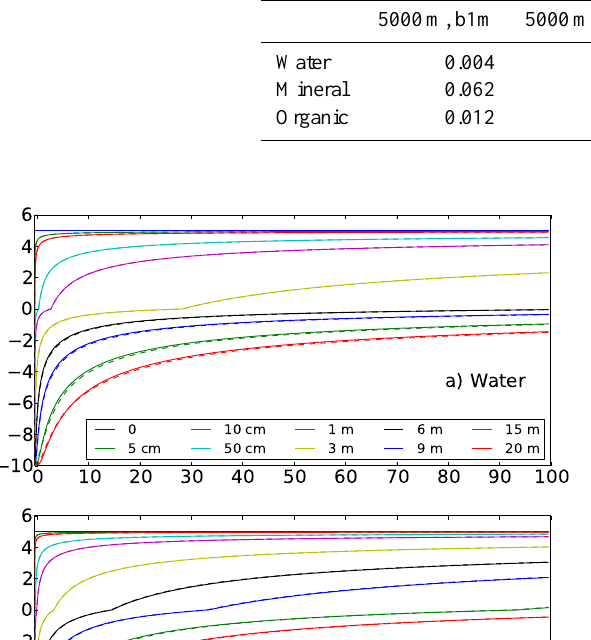
Table 4. The root mean squared error ( n = 36500) between the thawing fronts (m) from exact Neumann solutions and simulated thawing fronts from the DOS-TEM, with different combinations of total thickness (50, 500, and 5000m) and bottom-up forcing (b1m: bottom-up forcing at 1m below front; nobot: no bottom-up forcing) for different materials. 5000m, b1m